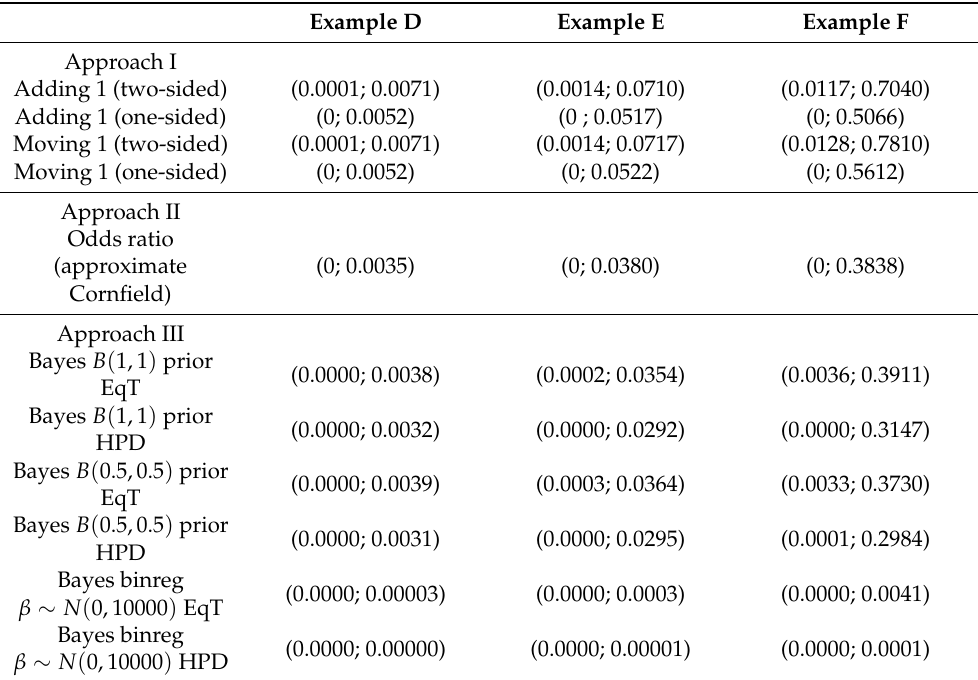
Table 3. Results: reported intervals are 95% CIs for frequentist methods and 95% CrI for Bayesian methods. (Note: 0 indicates an estimate formally forced to be 0, while 0.000 indicates an estimate numerically within 0.0005 of